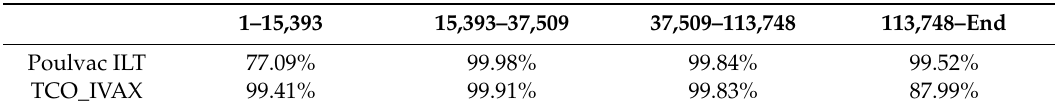
Table 5. Percentages of nucleotide identity of vaccines CEO-Poulvac ILT ® and TCO-LT-IVAX ® with British Columbia ILTV isolate (BC-10-1122) indicated by bootscan.